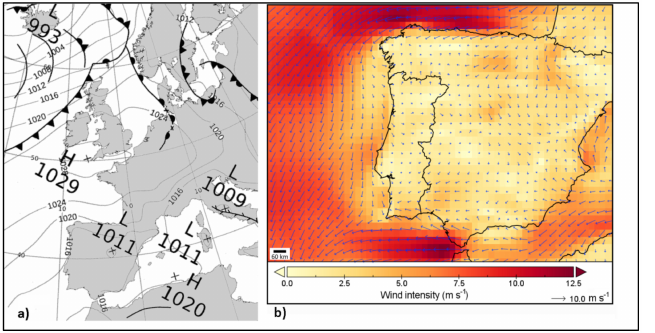
Figure 4. ( a ) Mean sea-level pressure (solid contours, 4-hPa intervals) over the Northeast Atlantic (adapted from Uk Met Office), and ( b ) wind intensity and direction (arrows) over the Iberian Peninsula (ERA5 hourly reanalysis) at 12:00 UTC, 17 June 2017.